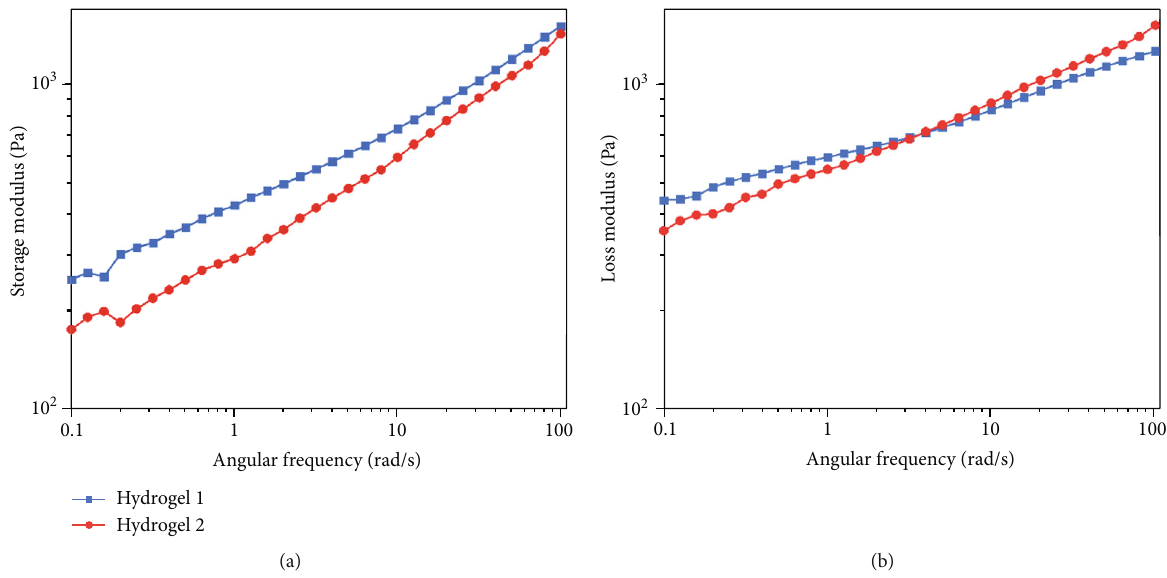
Figure 10: (a) shows the change law of storage modulus of hydrogel with increasing frequency, and (b) shows the change law of loss modulus and storage modulus of hydrogel with increasing frequency.